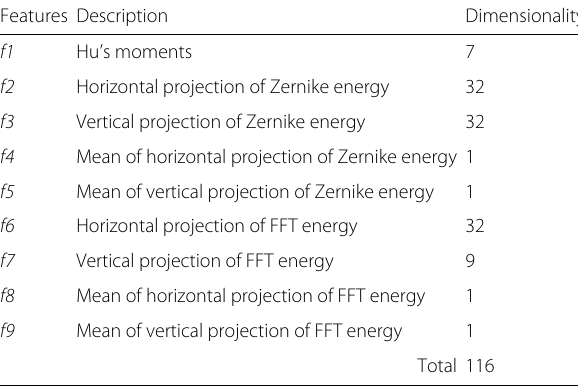
Table 5 Summary of frame features employed in our study Features